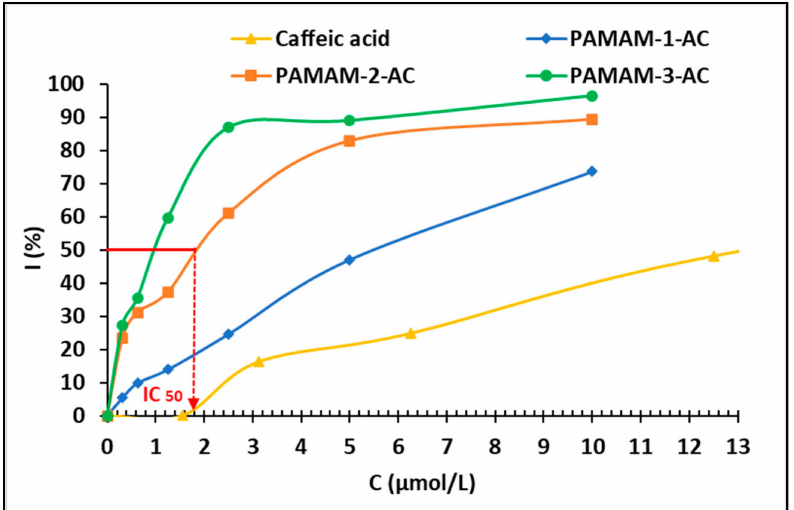
Figure 1. The inhibition of DPPH (300 µ M) by caffeic acid-derived PAMAM dendrimers.